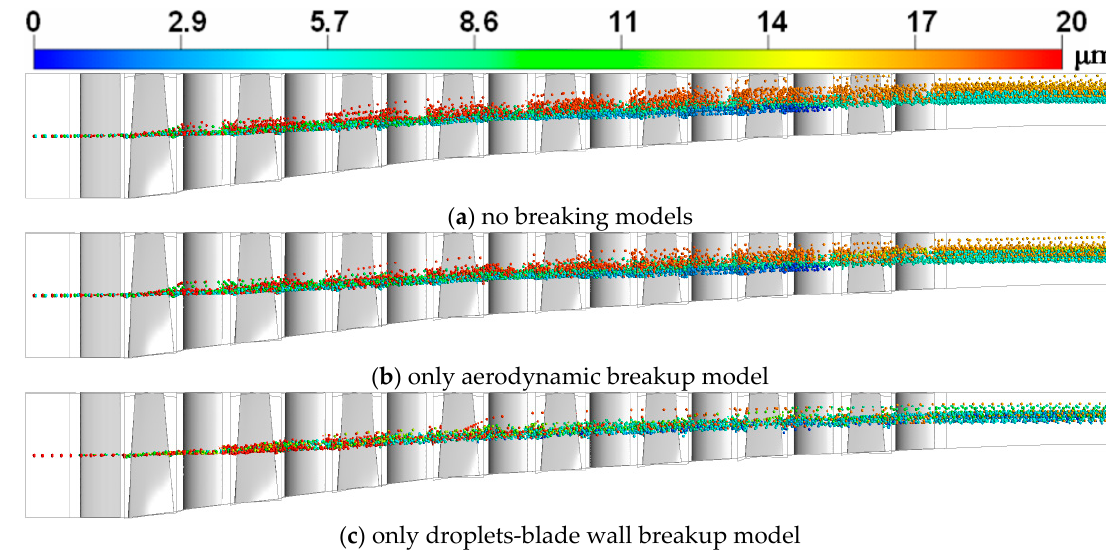
Figure 14. Three group of droplets trajectories inject from inlet 50% span under 90% rotating speed.